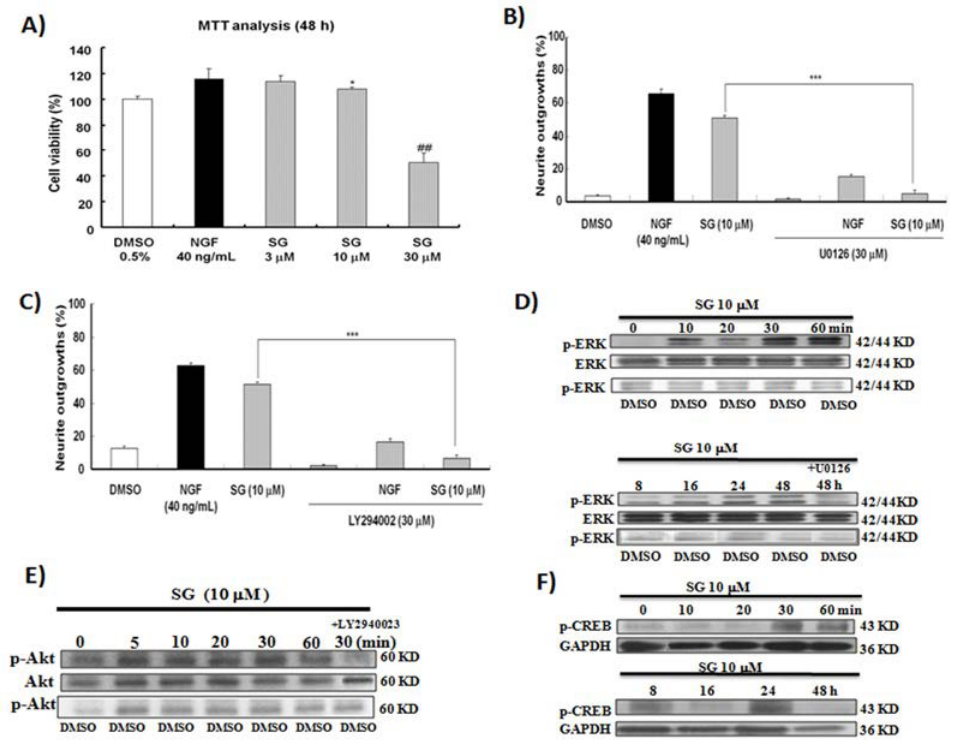
Figure 5. MTT analysis, effects of ERK and PI3K inhibitors on the neurite outgrowth of PC12 cells induced by SG and Western blot analysis results. ( A ) Results of MTT